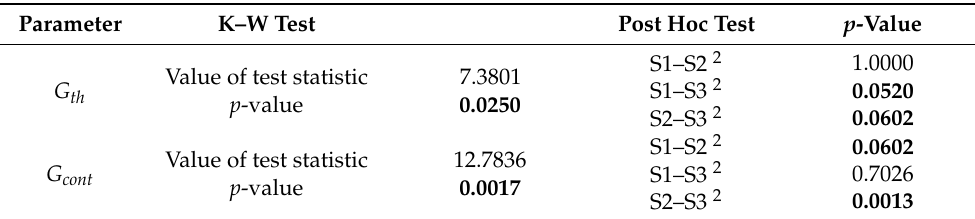
Table 8. Results of the statistical analysis for three groups: S1, S2, and S3 1 .